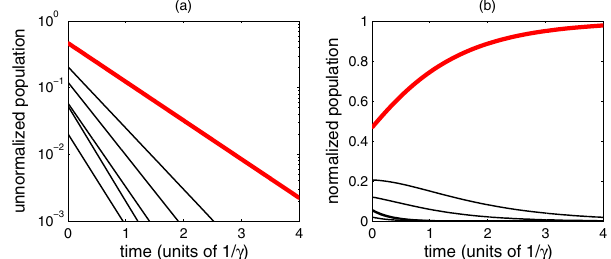
FIG. 2. Population in the six slowest-decaying eigenstates of H during the non-Hermitian evolution (a) without normaliza- eff tion and (b) with normalization. This is from exact diagonaliza- tion of N ¼ 10 atoms with open boundary conditions, the initial condition j ↓↓ (cid:3) (cid:3) (cid:3) ↓ i , J 0 ¼ 0 . 12 γ , and J ¼ 0 . The thick red line denotes the steady